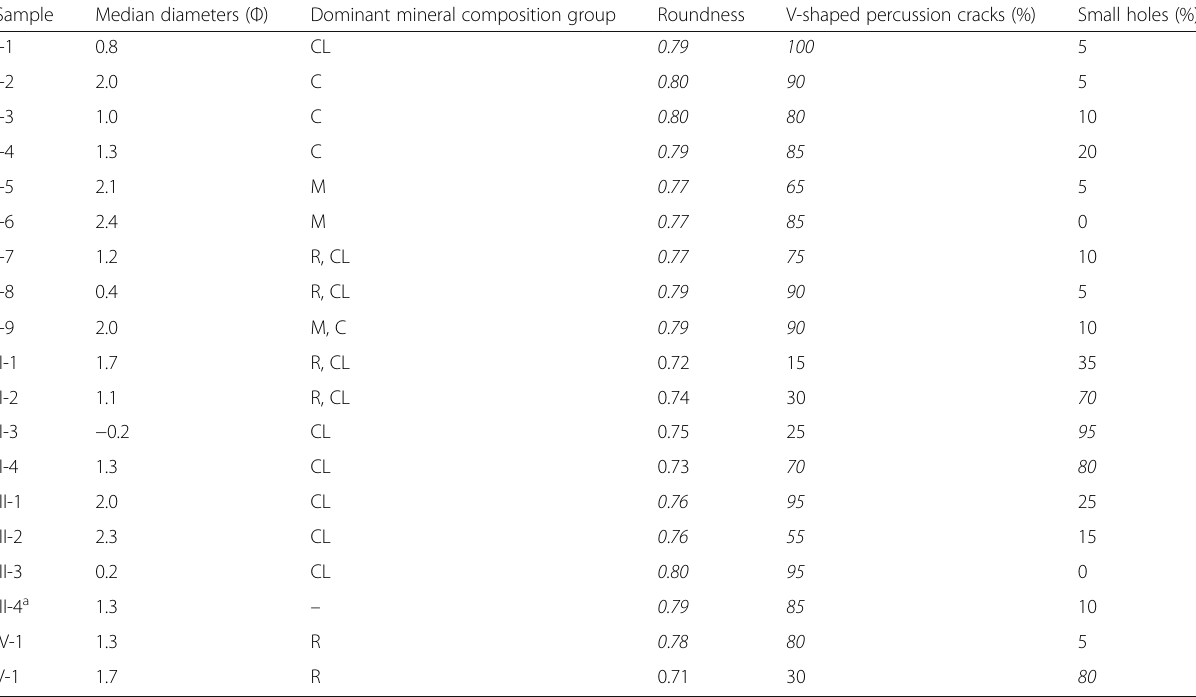
Table 2 Results of grain size distribution, mineral composition ( n > 500), roundness of quartz, and frequency of two characteristics microtextures. Italic characters show > 0.75 (roundness) and > 50% (frequency of v-shaped percussion cracks and small